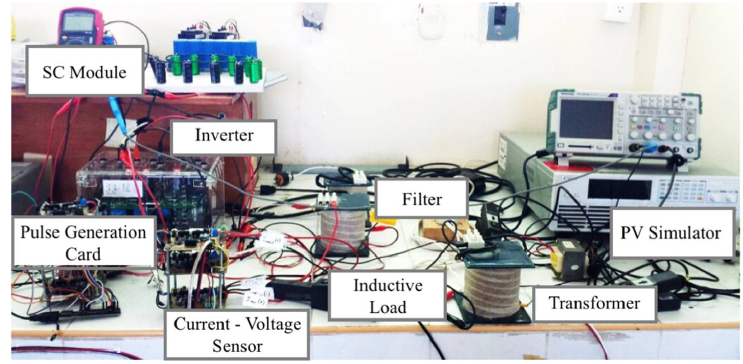
Figure 10. Experimental test bank of the system.